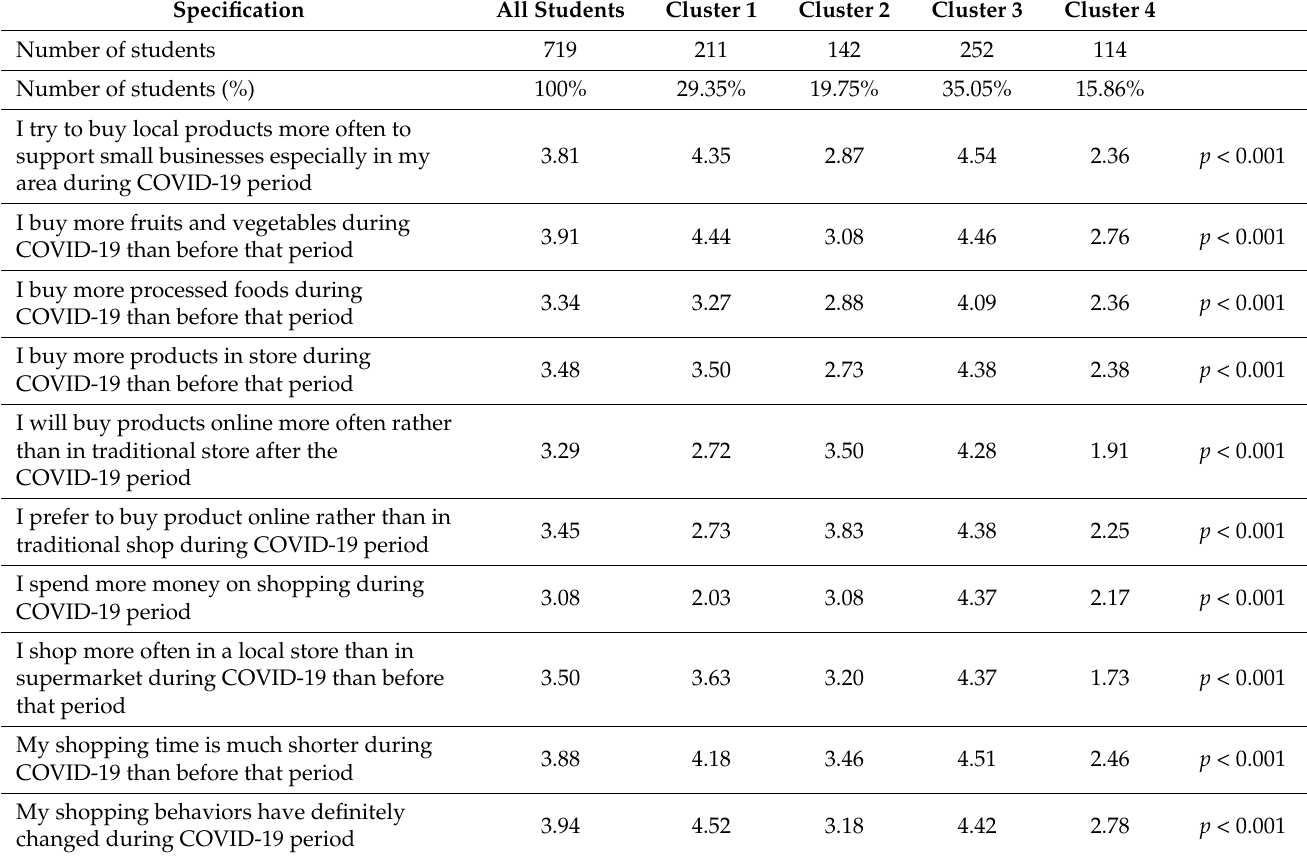
Table 6. Cluster analysis: all international